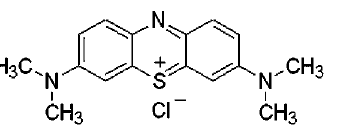
Figure 1. Chemical structure of methylene blue (MB).